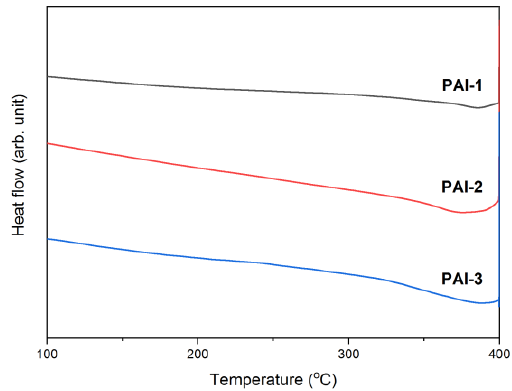
Figure 6. DSC curves of PAIs (second heating scan, heating rate: 10 °C/min, in N 2 ). The linear coefficients of thermal expansion (CTEs) of the PAI films were in the range of 7.8 to 44.8 ppm/ °C in the third run. In general, rigid-rod polymers with more rectilinear structures show lower CTE values due to the high parallel chain alignment in the film plane [31]. The PAIs described here also follow this general structure–property relationship, and the CTE of the polymer was sharply decreased with the increasing portion of rigid and linear TFMB/PMDA imide segments (Figure 7a). In addition, it is noteworthy that the CTE value of the PAIs was linearly decreased with the imide bond content (Figure 7b).